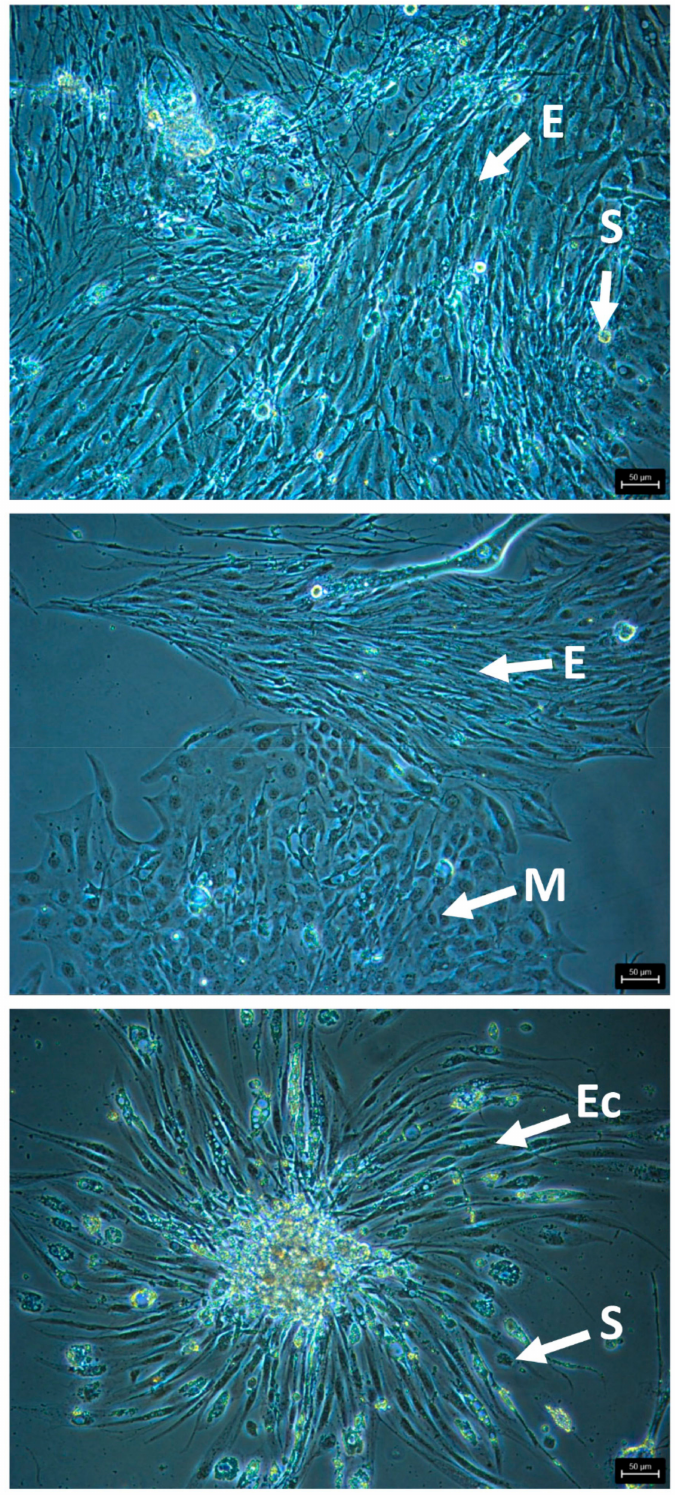
Figure 2. Representative images of attached, healthy cells from honey bee egg cell cultures in CLG#2 + FBS, passaged once, showing morphologically distinct cell types. E, elongated cells; S, spherical cells; M, multi-sided cells; Ec, elongated cells growing out of a cell clump. Bars, 50 µ